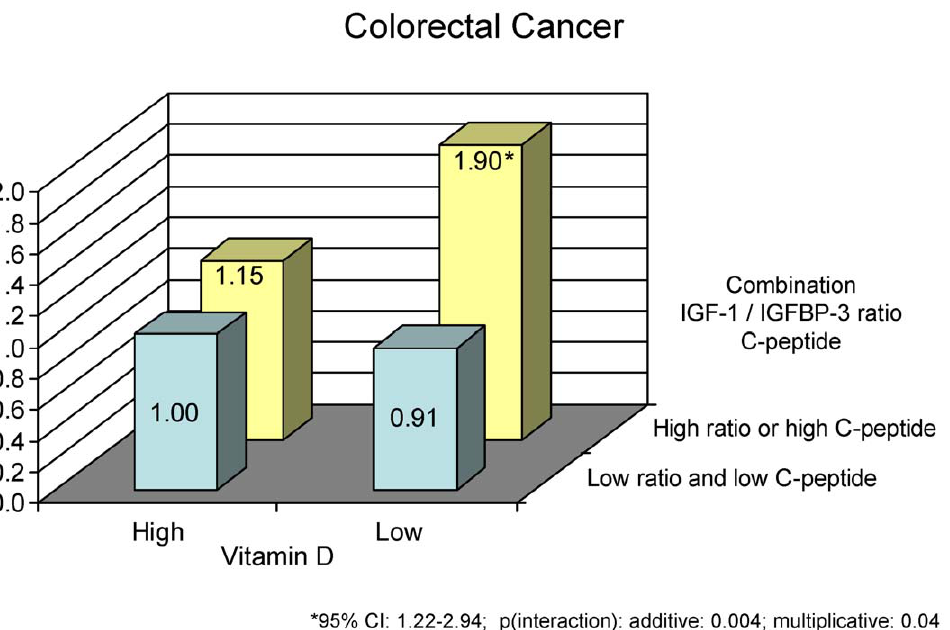
Figure 2. Multivariate adjusted odds ratios and 95% confidence intervals of colorectal cancer by plasma 25(OH)D levels and combinations of C-peptide levels and molar IGF-1/IGFBP3 ratio, HPFS and NHS combined.